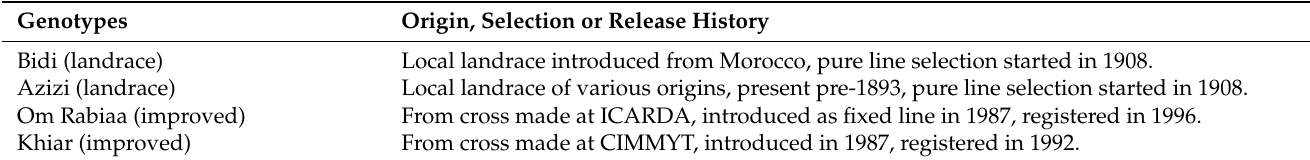
Table 1. Origin and release history of landraces and improved genotypes used in this study [24]. Genotypes Origin, Selection or Release History Local landrace introduced from Morocco, pure line selection started in 1908. Local landrace of various origins, present pre-1893, pure line selection started in 1908.